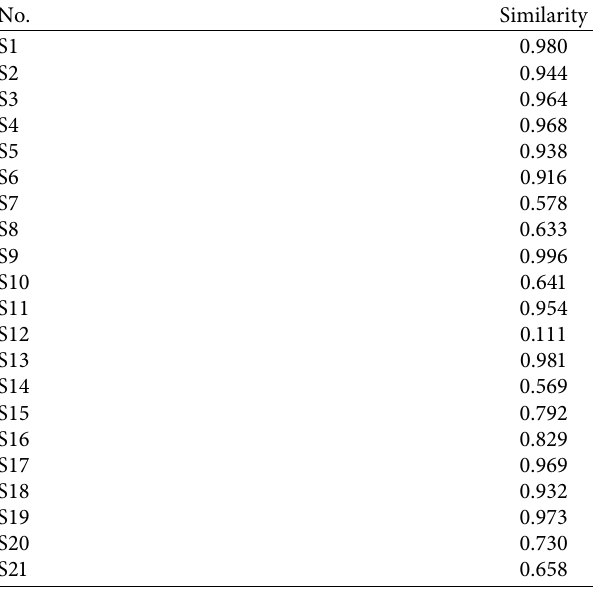
Table 2: Similarity evaluation of 47 batches of Acacia catechu